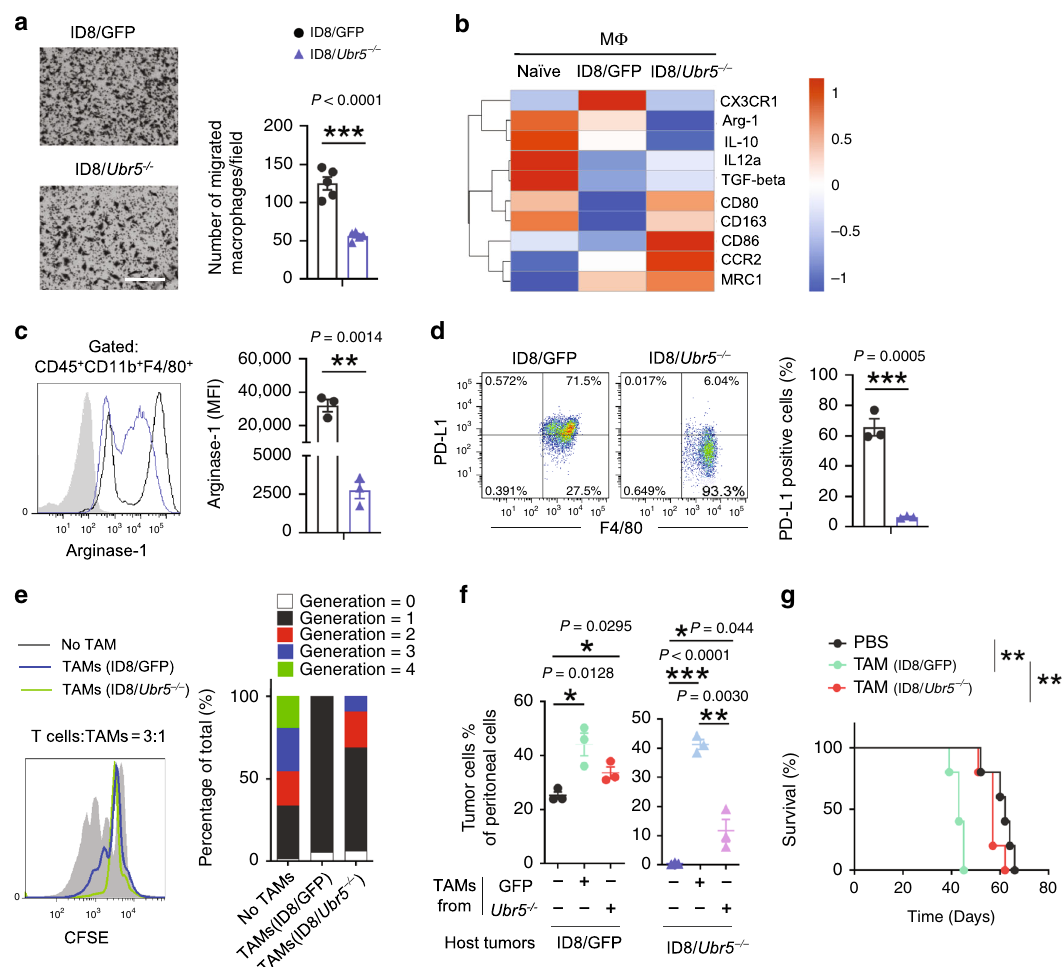
Fig. 4 Functional impairment of macrophages in Ubr5 -null tumors. a Peritoneal macrophages were isolated and starved overnight before loaded into upper chamber with ID8 cells cultured at the bottom. Migrated cells were assessed after 16 h incubation ( n = 5 biologically independent samples per group and an average of fi ve fi elds acquired from each sample). Scale bars: 200 μ m. b Heat map representation of differentially expressed M1/M2 genes in naïve macrophages and TAMs. c Representative FACS analysis of intracellular Arginase-1 in CD45 + CD11b + F4/80 + cells and quanti fi cation expressed as mean fl orescence intensity (MFI) of Arginase-1 ( n = 3 mice per group). d Representative FACS analysis and proportion of PD-L1 + cells gated on CD45 + CD11b + F4/80 + cells ( n = 3 mice per group). e T cell proliferation suppression assay. CFSE-labeled T cells from naïve mice were stimulated with anti-CD3 and CD28 antibodies and co-cultured for 3 days with TAMs isolated from ID8/GFP or ID8/ Ubr5 − / − bearing mice at 3:1 ratio ( n = 3 mice per group). f Proportion of Muc16 + CD45 − tumor cells with or without exogenous TAMs on day 45 post-tumor inoculation ( n = 3 mice per group). g Kaplan – Meier curves showing the survival of ID8 bearing mice with or without exogenous TAMs ( n = 5 mice per group), P = 0.0026, log-rank test. Data are representative of two independent experiments with similar results. Data are presented as mean ± SEM, unpaired two-sided Student ’ s t -test with no correction for multiple comparison,* P <0.05, ** P <0.01, *** P <0.001. Source data are provided as a Source Data fi